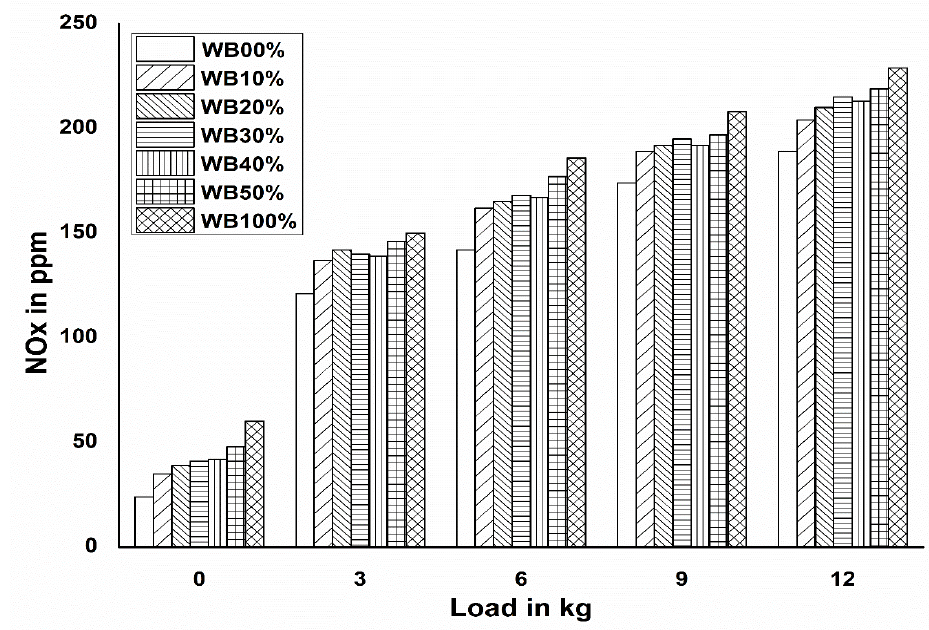
Figure 9. NO x emissions ’ variation against load for biodiesel and the blends (kg).